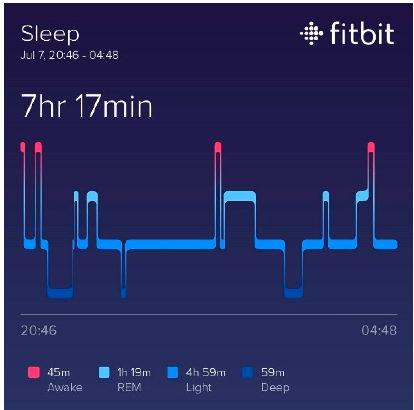
Figure A18. Saigon,